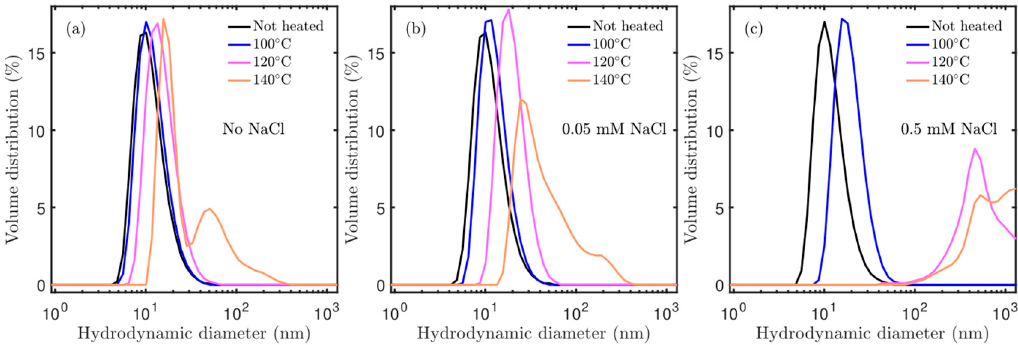
Figure 8. Particle size distributions after autoclaving at the indicated temperatures measured with DLS. ( a ) No NaCl; ( b ) 0.05 mM NaCl; ( c ) 0.5 mM NaCl.